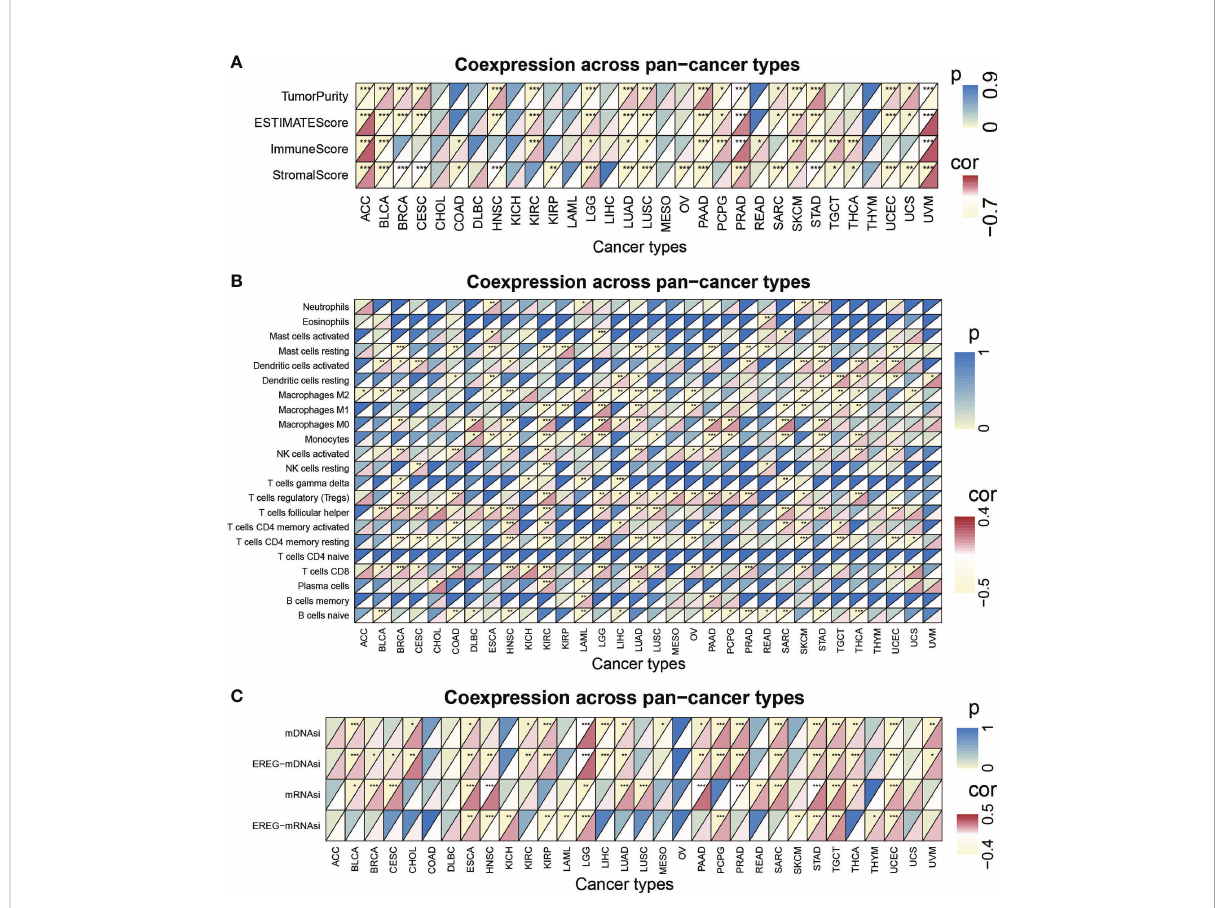
FIGURE 7 The pan-cancer analysis of risk score model. (A) Tumor purity, ESTIMATES score, immune score, and the stromal score of 32 types of tumors. (B) The TME-in fi ltrating cell of 32 types of tumors. (C) The stemness index difference of 32 types of tumors. (*p-value < 0.05; **p-value < 0.01; ***p-value <